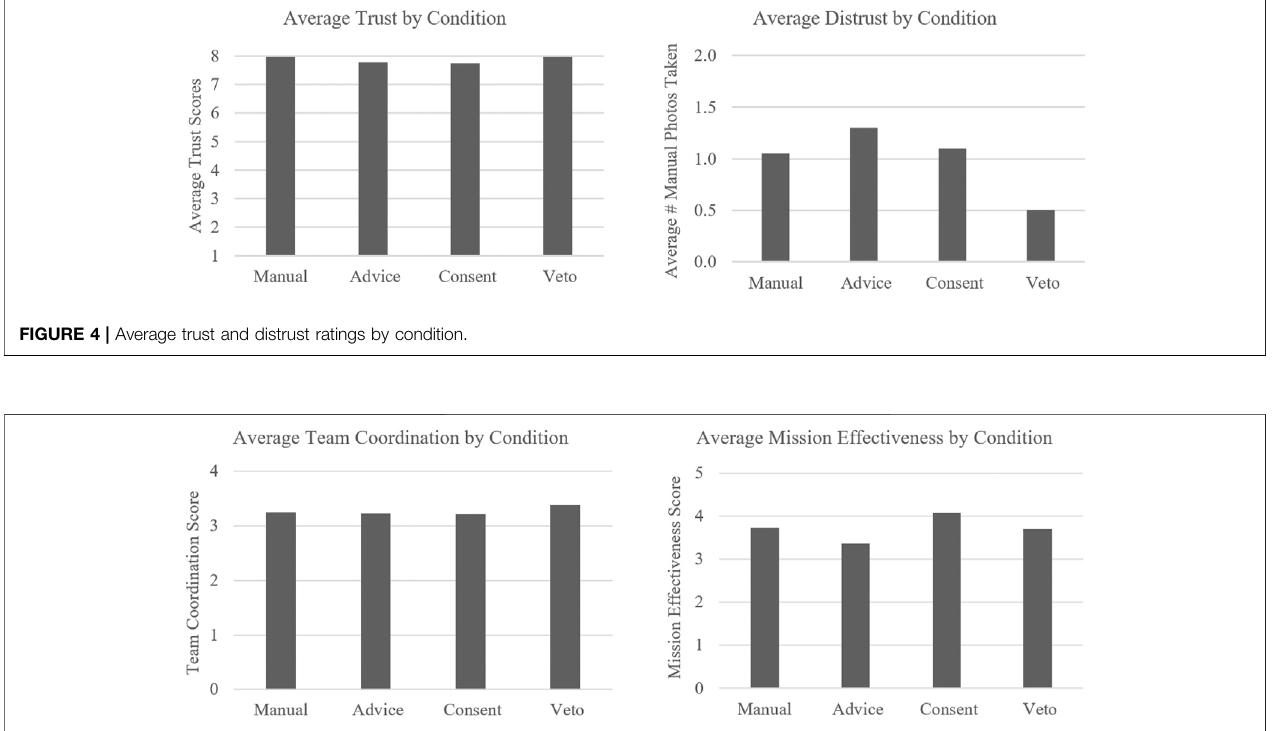
FIGURE 5 | Average team coordination and mission effectiveness scores by